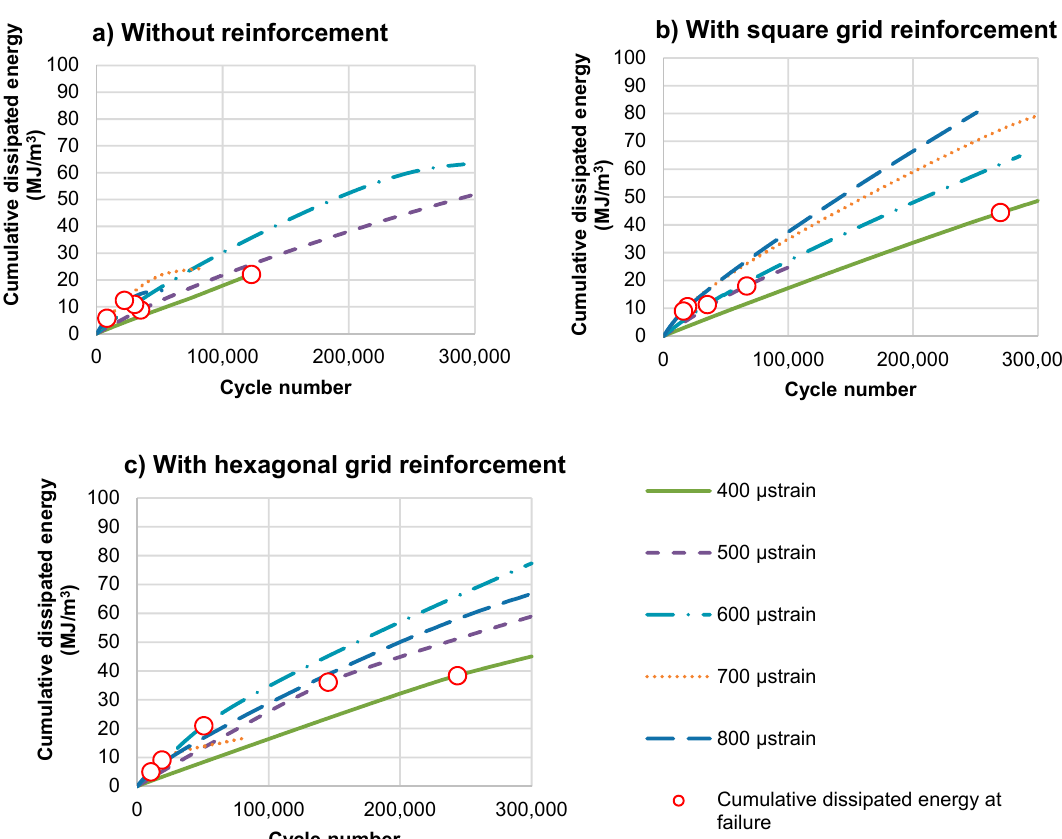
Figure 14. Accumulation of dissipated energy in consecutive test cycles for double-layered asphalt concrete beams: ( a ) without reinforcement, ( b ) with square grid reinforcement and ( c ) with hexagonal grid reinforcement. Figure 15 shows a comparison of the total dissipated energy from the start of the test to fatigue failure defined as a decrease in system stiffness to 50% of the initial value.